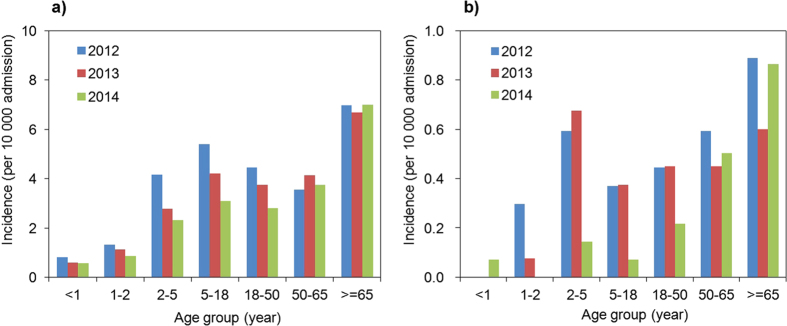
Changes in estimated age-specific incidence of (a) pneumococcal disease and (b) invasive pneumococcal disease during 2012–2014.